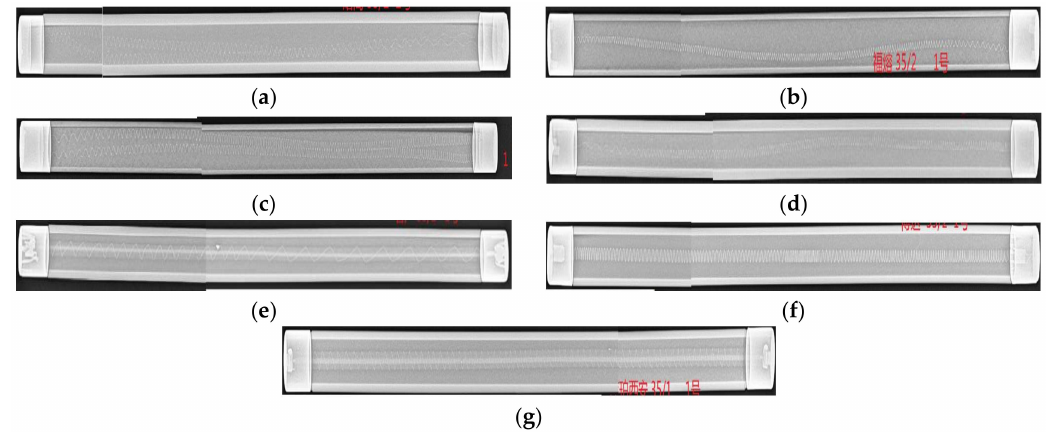
Figure 14. X-ray detector.